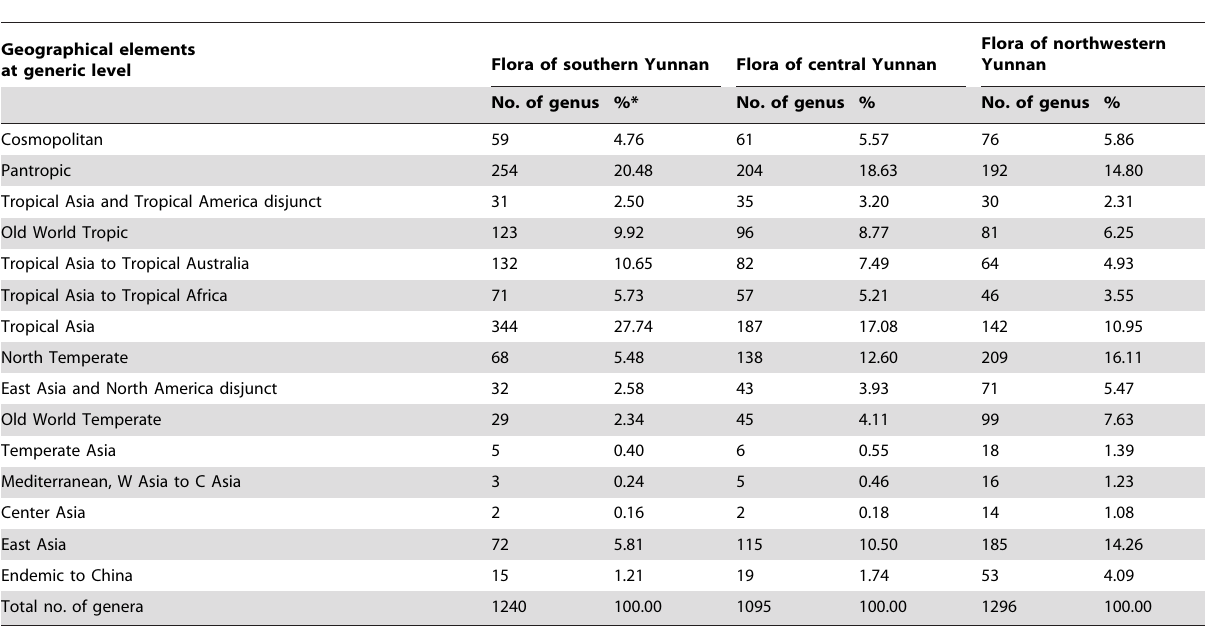
Table 4. Geographical elements of seed plants at the generic level of these three compared floras.